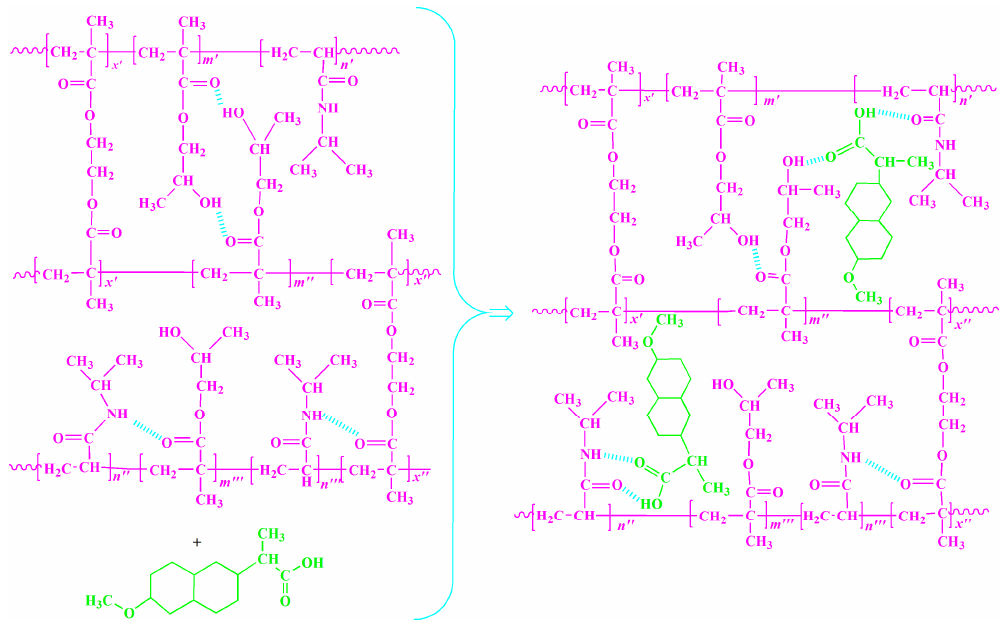
Figure 7. The naproxen incorporation into the p( N iPAm- co -HPMet) hydrogels.